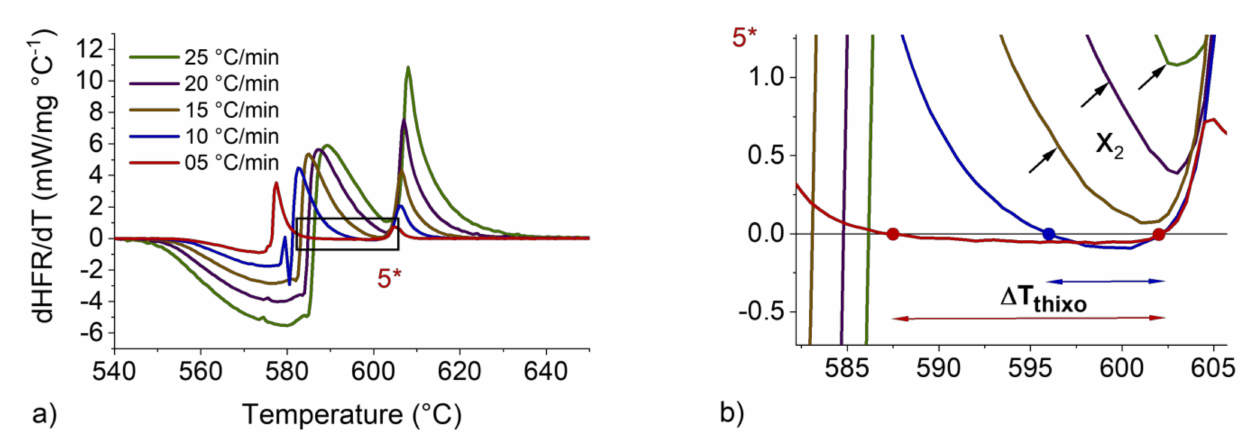
Figure 10. dHFR/dT vs. T curve for 7 wt.%Si with heating rates from 5 to 25 ◦ C/min and sample mass of 20 mg ( a ). Magnification at the ∆ T THIXO zone ( b ).